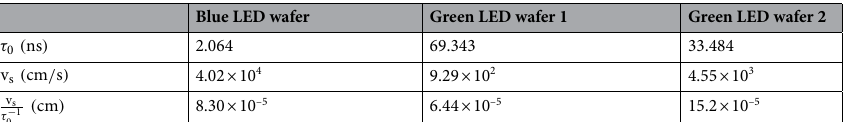
Table 1. Measured carrier lifetime of each bare wafer, surface recombination velocity, and suggested factor, v s /τ − 1 0 , for three examined LED